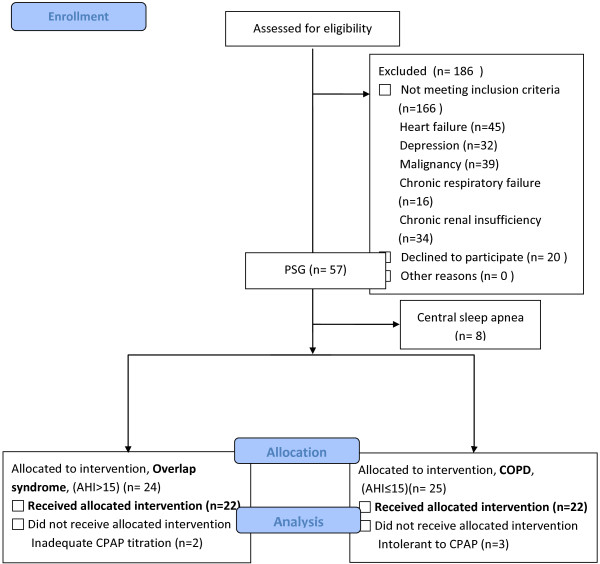
Flow chart of the study design.